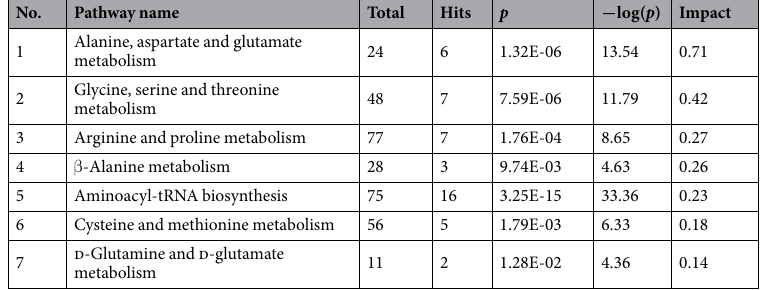
Table 1. List of metabolic pathways associated with melanoma metastasis. Pathways were identified by a pathway analysis using